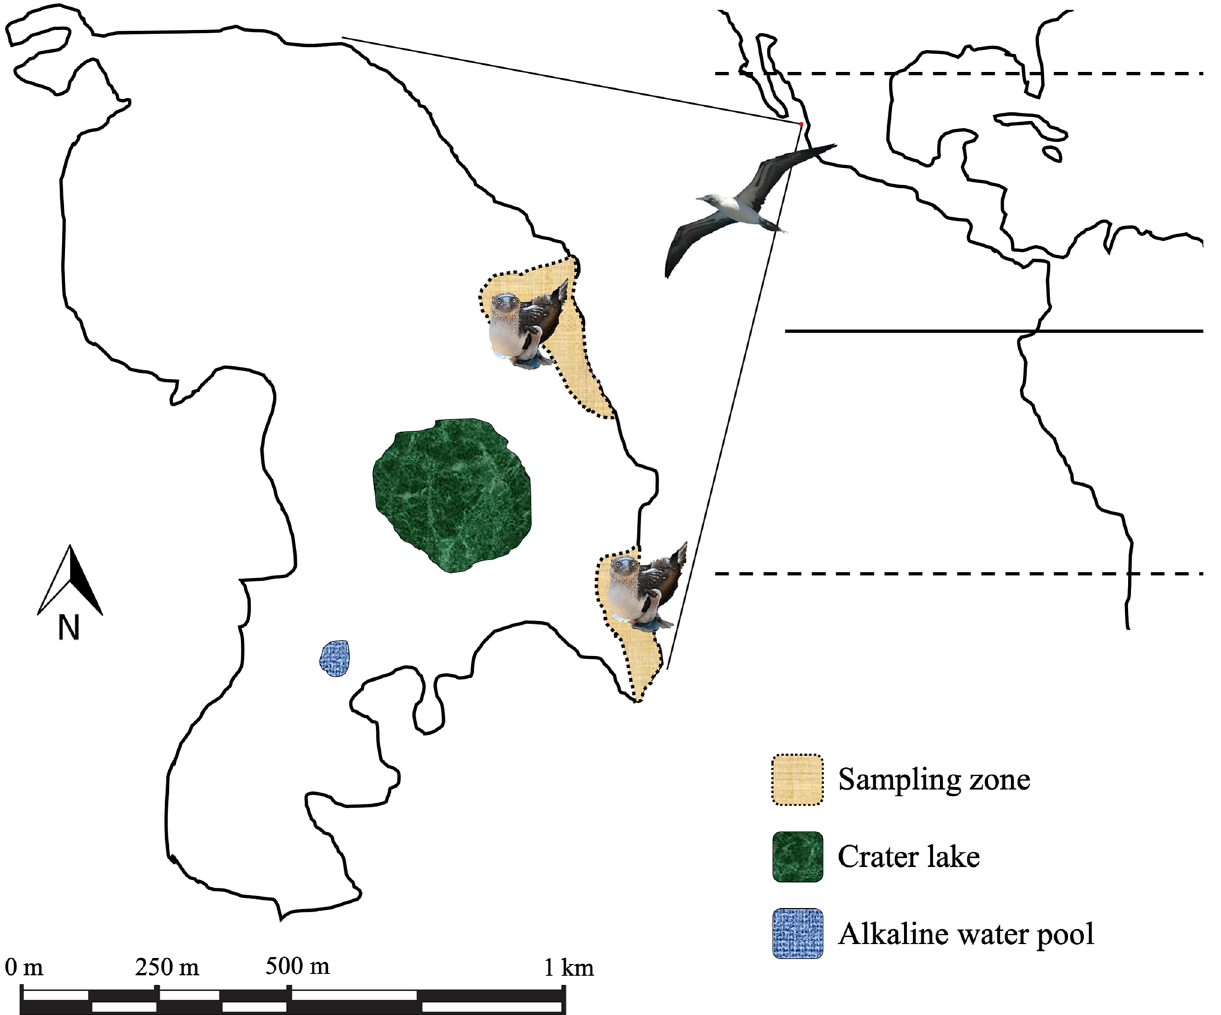
Figure 1. Isla Isabel, Mexico (21° 52 ′ N, 105° 54 ′ W) in the Eastern Tropical North Pacific. The study area comprised two fixed plots that measured in total 26,889 m 2 , where reproduction of blue-footed boobies is monitored every year since 1981. Blood samples were taken in March–April 2019. Photos courtesy of